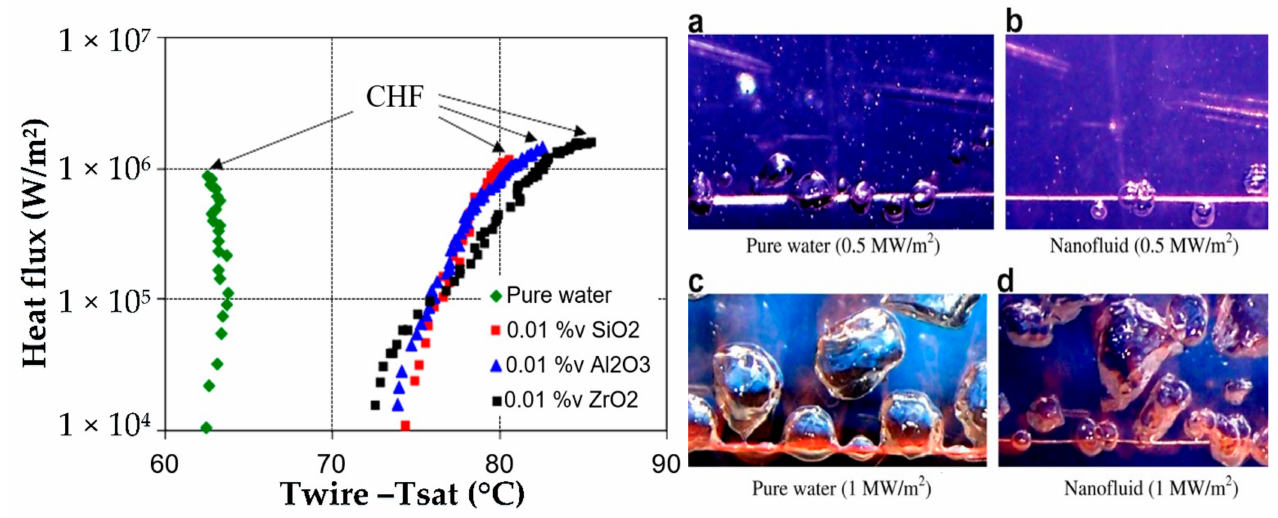
Figure 7. Boiling curves for stainless steel wire; pool boiling of pure water and 0.01 vol.% alumina nanofluid at the same heat flux on stainless steel wire [84]. ( a – d ) presents the pool boiling response of fluid bubbles at same heat flux around the stainless steel